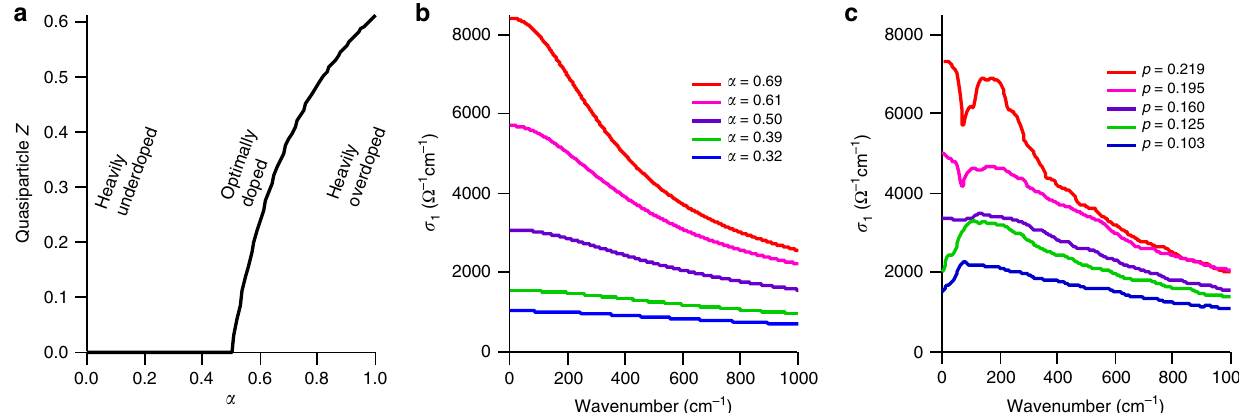
Fig. 5 Quasiparticle residue and optical conductivity. a The quasiparticle residue Z calculated using our PLL functional form (also see Supplementary Note 8). b Simulated and c measured normal state ( T = 300 K) optical conductivity (reconstructed from ref. 30 , see Supplementary Note 9) as a function of doping. In b α values were chosen to match the reported doping levels in c